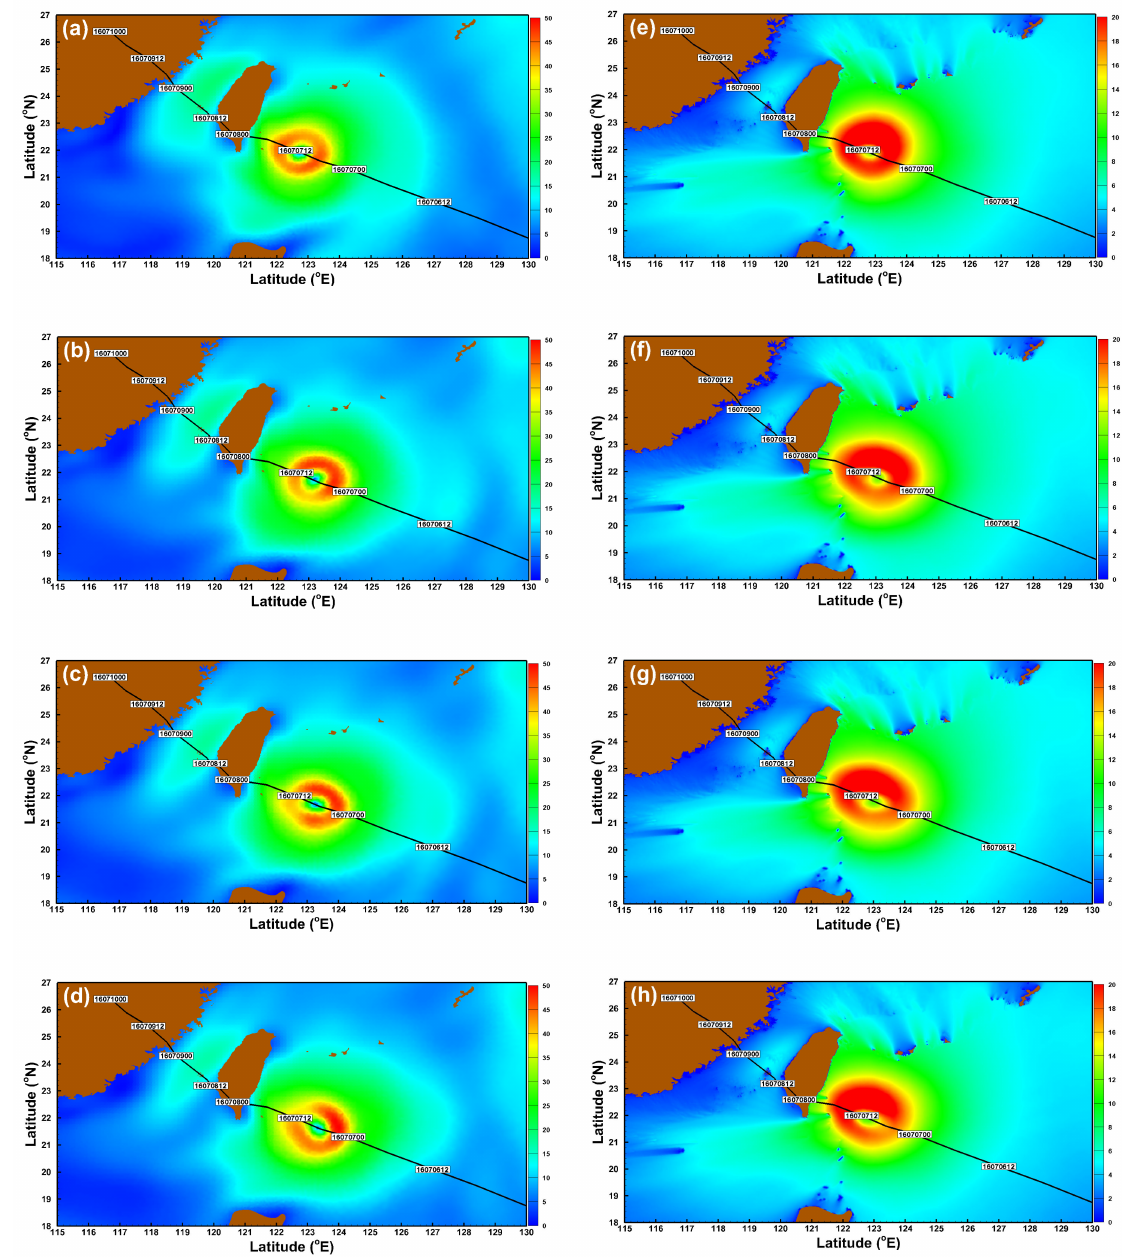
Figure 6. Instantaneous wind field distribution from CFSV2 with a spatial resolution of 0.205 ◦ and temporal resolutions of ( a ) 1 h, ( b ) 2 h, ( c ) 3 h, and ( d ) 6 h and their corresponding SWHs ( e – h ) during Super Typhoon Nepartak at 11:00 on 12 July in